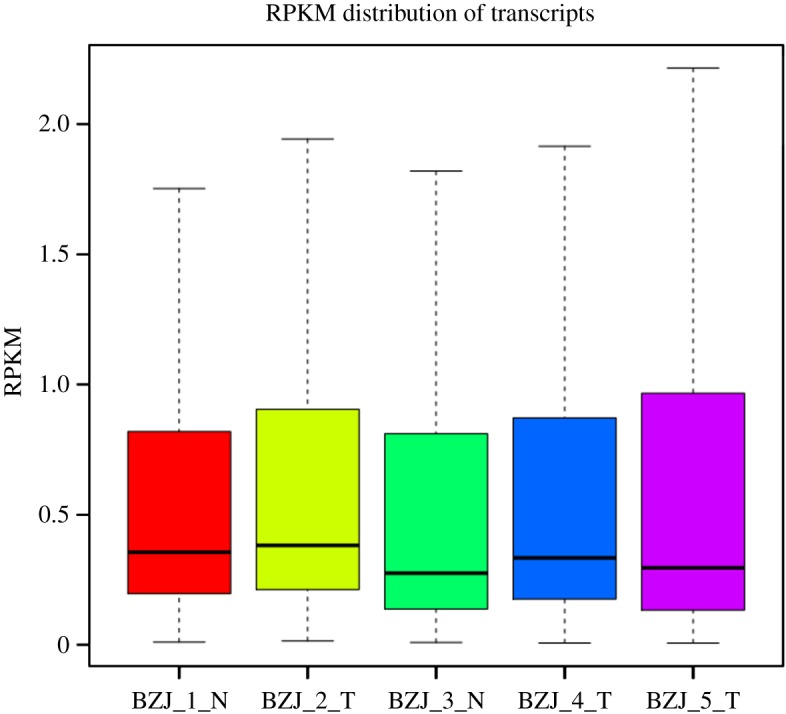
Expression levels of the five samples. The vertical scale shows the RPKM values of each sample. Every box region represents five statistics, which, from top to bottom are, in order, maximum, 3rd quartile, median, 1st quartile and minimum.